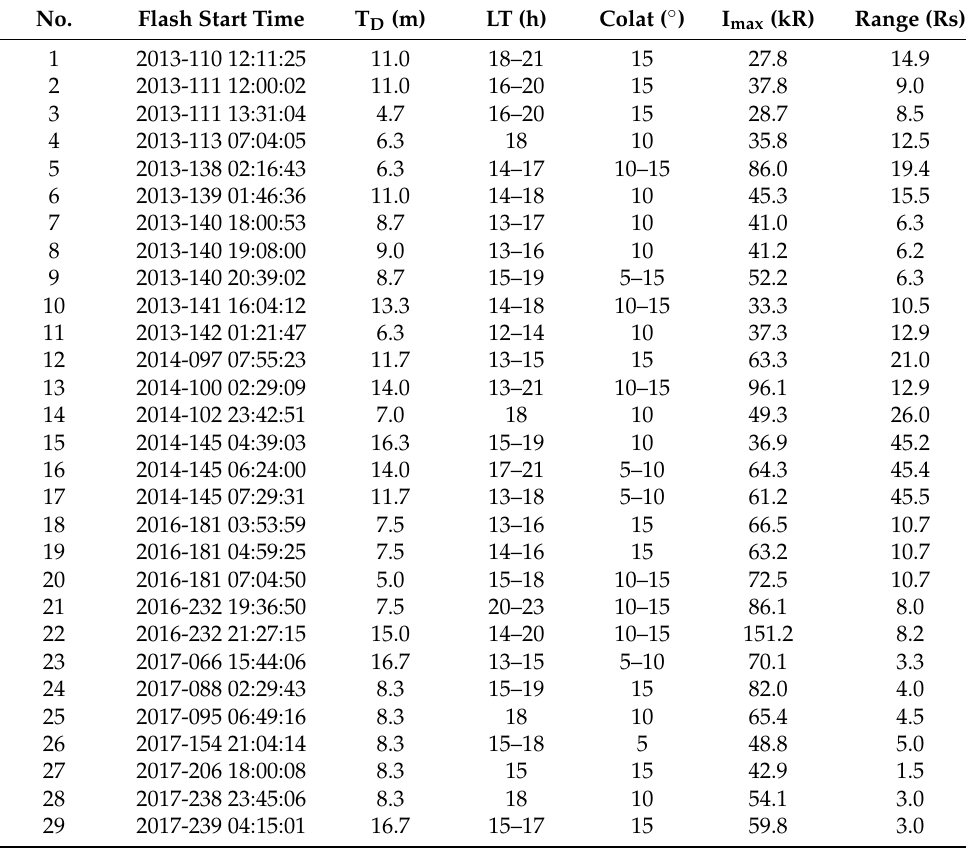
Table 1. List of transient flashes identified from HST images of Saturn’s northern hemisphere. The data sets are illustrated with flash sequence number, “Flash start time” representing the HST-to- Saturn subexposure in which each flash is first observed, T D the time duration (in minutes) in which the flashes were identifiable on the images, the spatial locations where flashes were switched on with respect to Local Time (in hour) and Colatitude (in degrees), the maximum intensity of each flashing episode measured in kiloRayleigh, and the average Cassini’s range (in saturnian radii) away from the planet during the flash